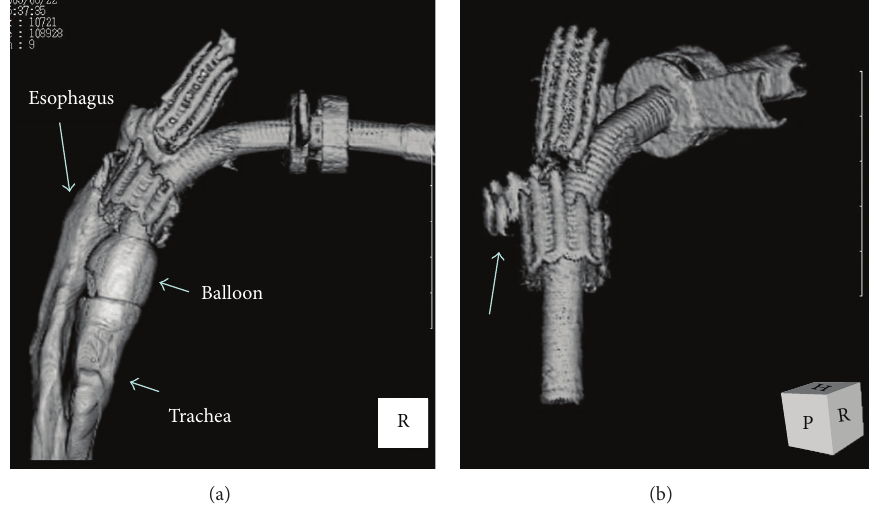
Figure 2: Reconstruction pictures on computed tomography. (a) The spatial relationship of the trachea, esophagus, stent, and tracheal tube was shown on CT. (b) The destroyed stent with a section existing outside of the trachea was also shown on CT